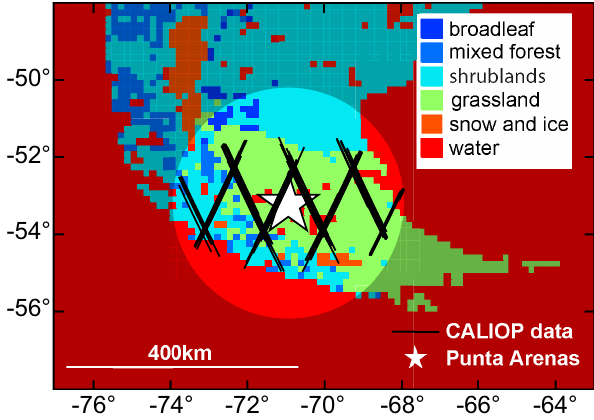
Figure 6. International Geosphere–Biosphere Programme (IGBP, 1990) surface type map of southern South America and selected CALIOP cross sections within 200km of Punta